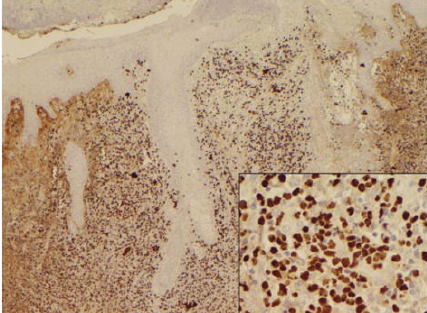
Figure 4: Epstein-Barr virus encoded ribonucleic acid (EBER) in situ hybridization showed strong nuclear staining in the majority of cells. Inset is area of higher